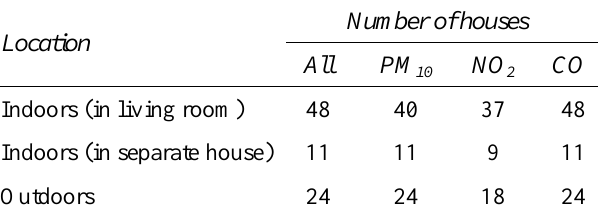
Table 1: Distribution of kitchen location in relation to pollutants sampled